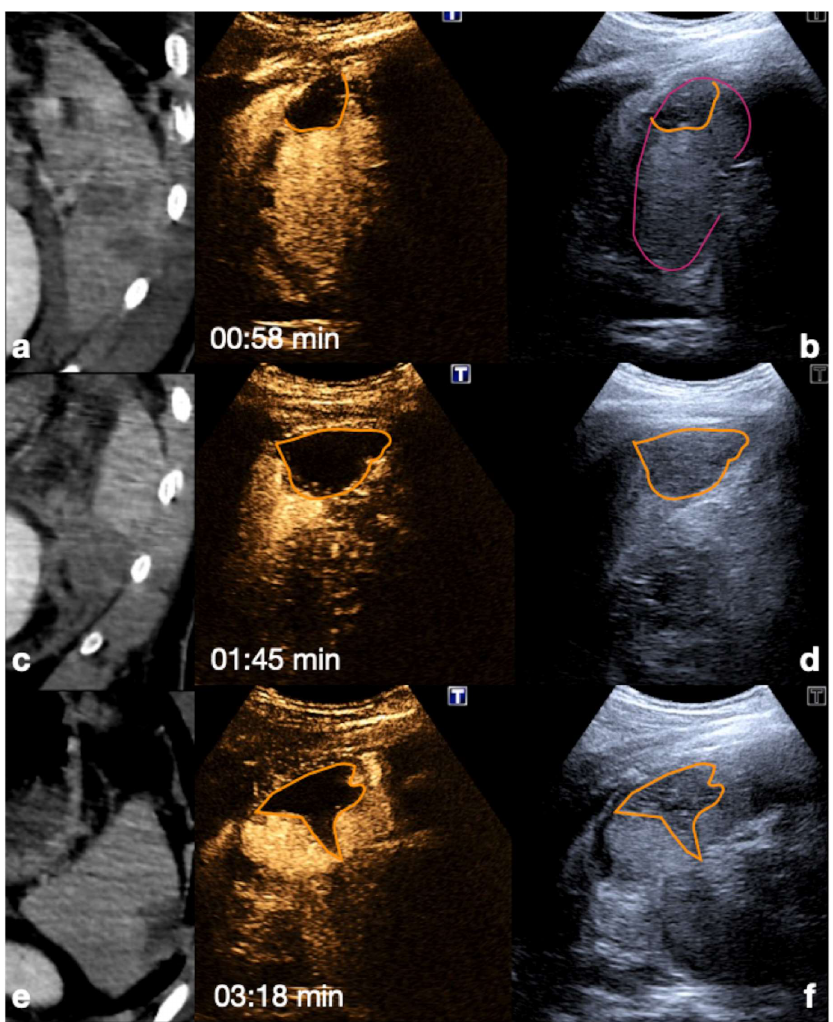
Figure 15. Admission CT ( a , c , e ) and follow-up CEUS ( b , d , f ) of the spleen in a 35 − year-old patient after a fall from height. Follow-up CEUS was performed seven days after the CT. Note at CEUS the progressive enhancement, at different time points, of the healthy spleen parenchyma in venous phase, clearly demarcated from the subcapsular hematomas ( b , orange line), from the contusion of the inferior-pole ( d , orange line) and from a sub-capsular laceration ( f , orange line). Figure 15 is reprinted with permission from Iacobellis F., Acampora C., Ponticiello C., Stavolo C., Scuderi M.G., Cinque T., Pinto A., Gagliardi N., Romano L. Technique and advantages of contrast-enhanced ul- trasound versus MDCT in the follow-up of solid organ injuries. Electronic Presentation Online Sys- tem (EPOSTM) Educational Exhibit ECR 2018 Iacobellis et al., doi: 10.1594/ecr2018/C-2010.